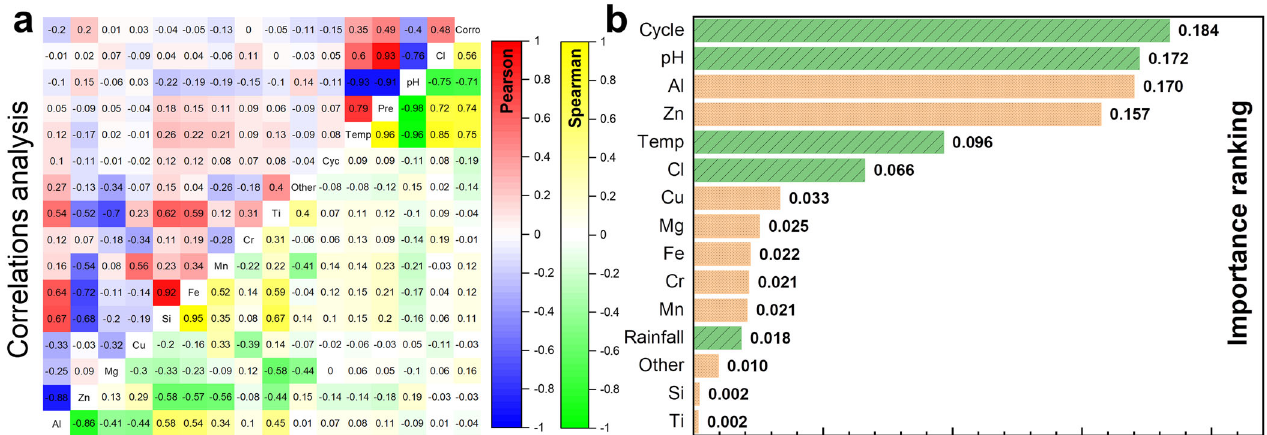
Fig. 3 Analysis of long-term exposure experiment data. a Pearson and Spearman correlation coef fi cient. b Importance ranking of corrosion data features based on the RF model.